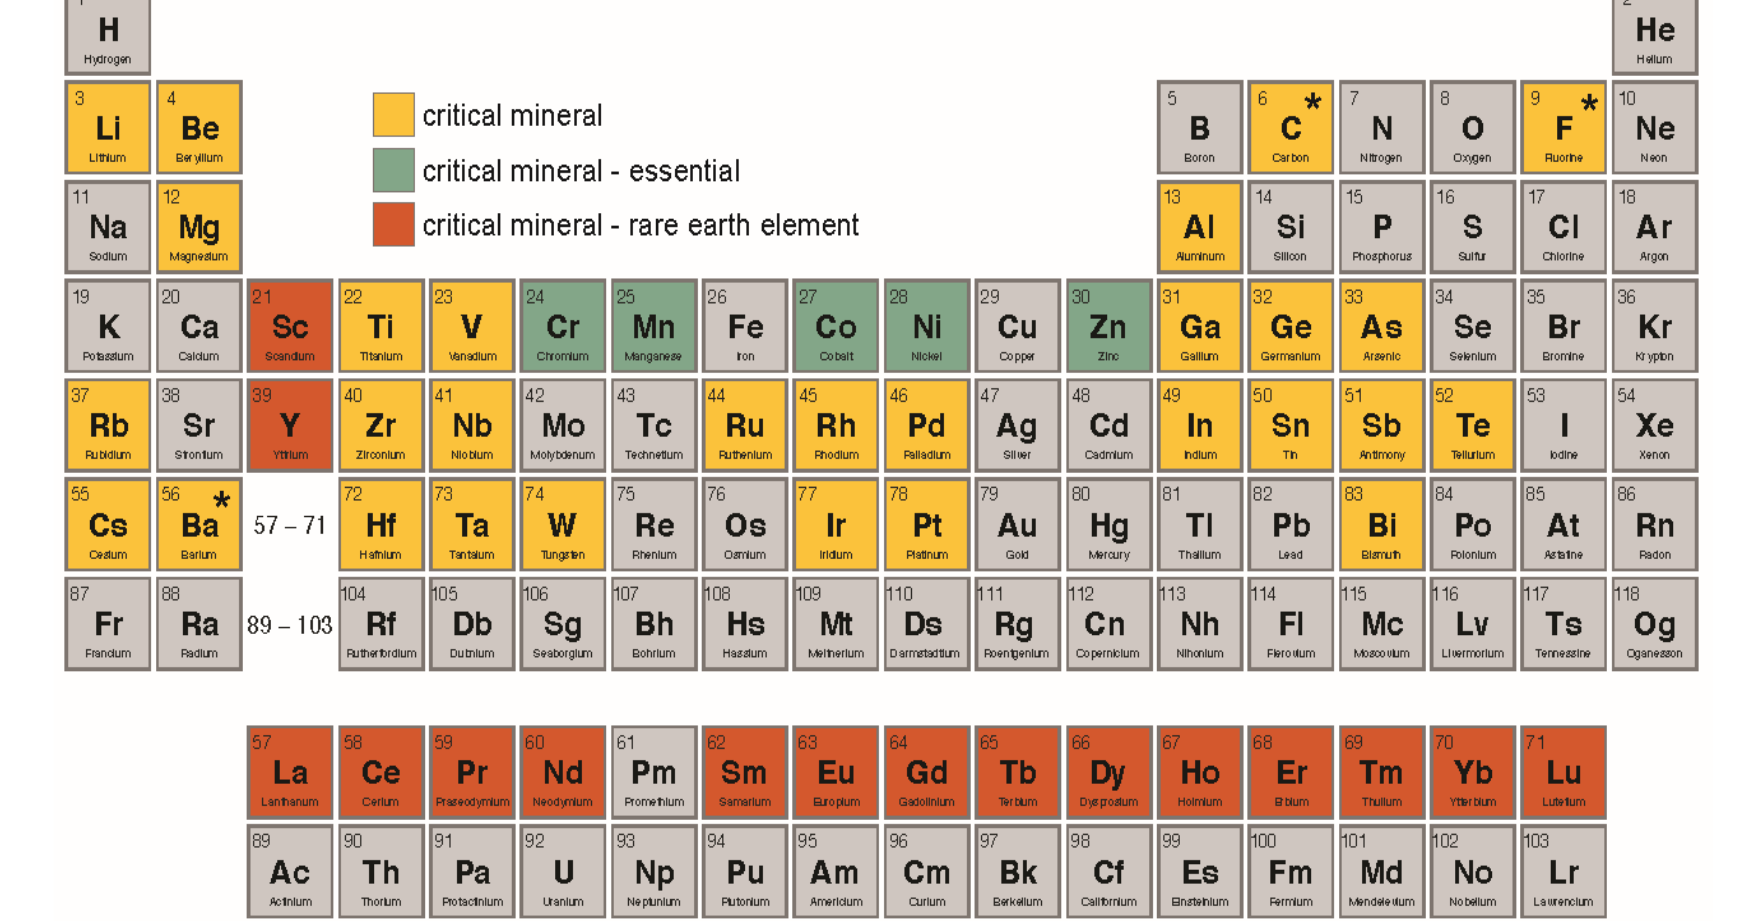
Figure 1. Periodic table highlighting critical elements and ore components defined as critical minerals (CM) in 2022 [6]. Of the CM (highlighted in yellow, green, or orange), the nutrients currently considered essential for humans are green and the rare earth elements are orange [11,16–20].